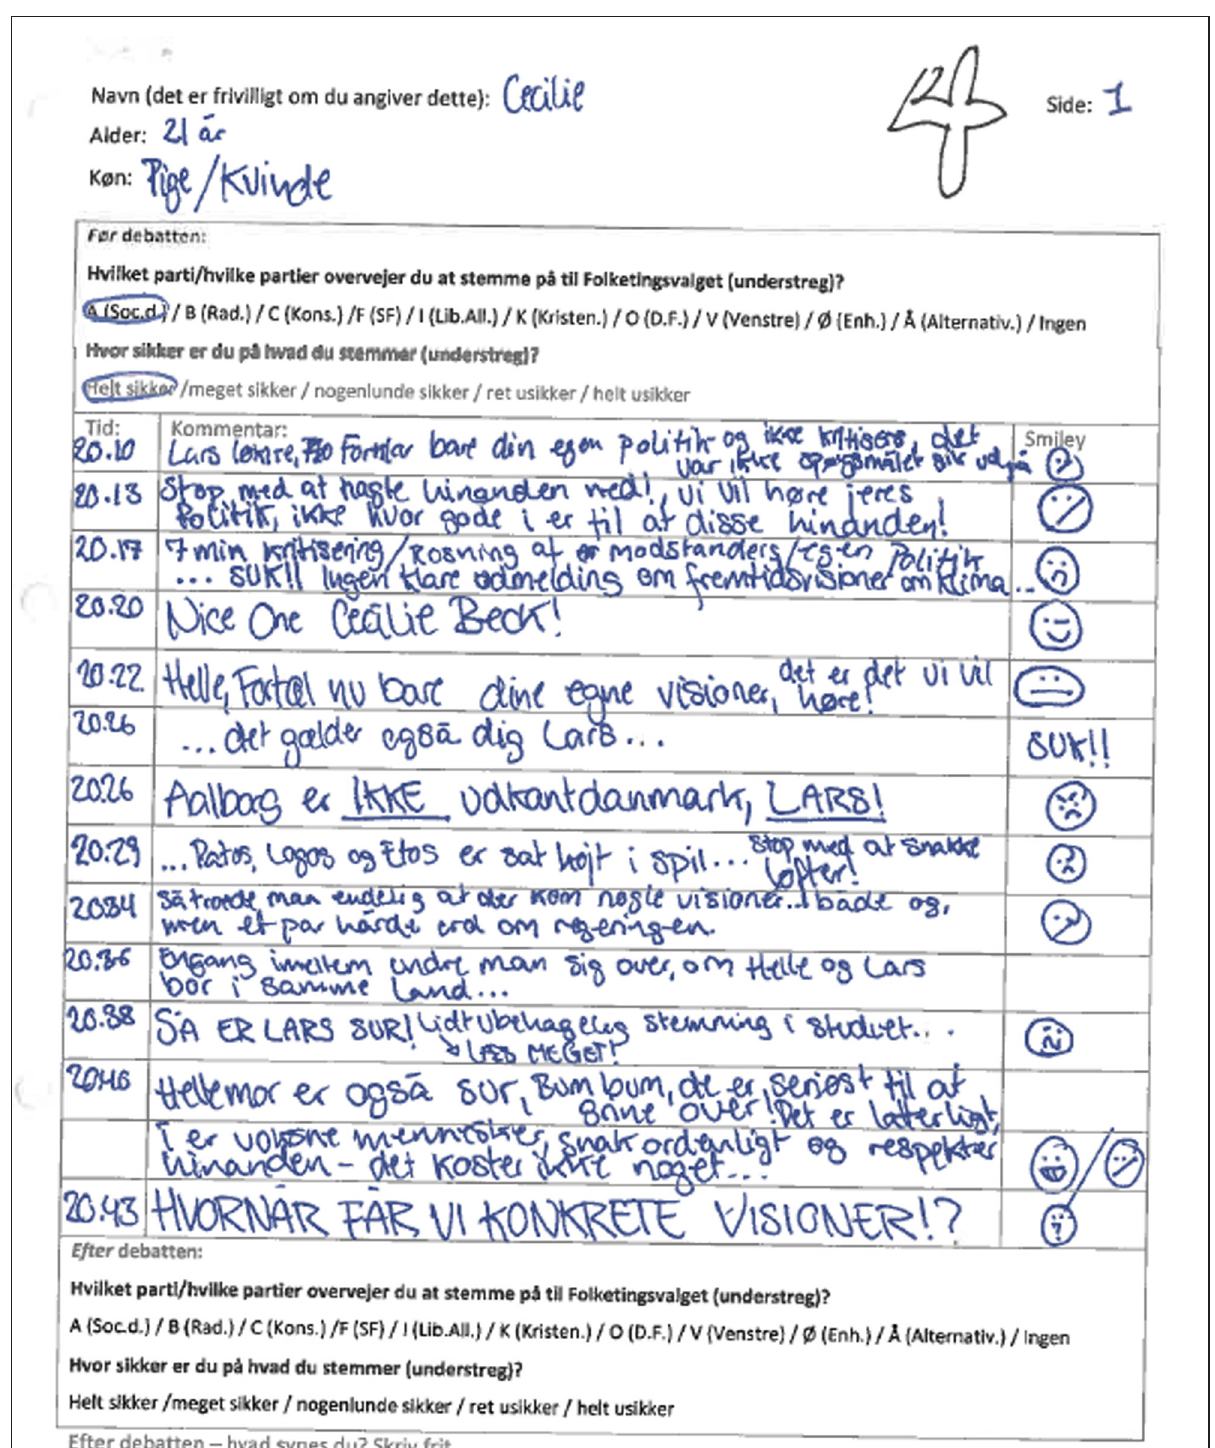
Figure 1: A page of a filled-in response sheet from the study reported in the